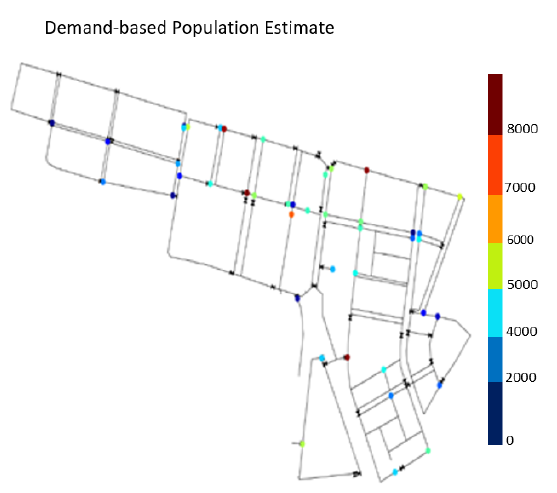
Figure 4. Population distribution based on water